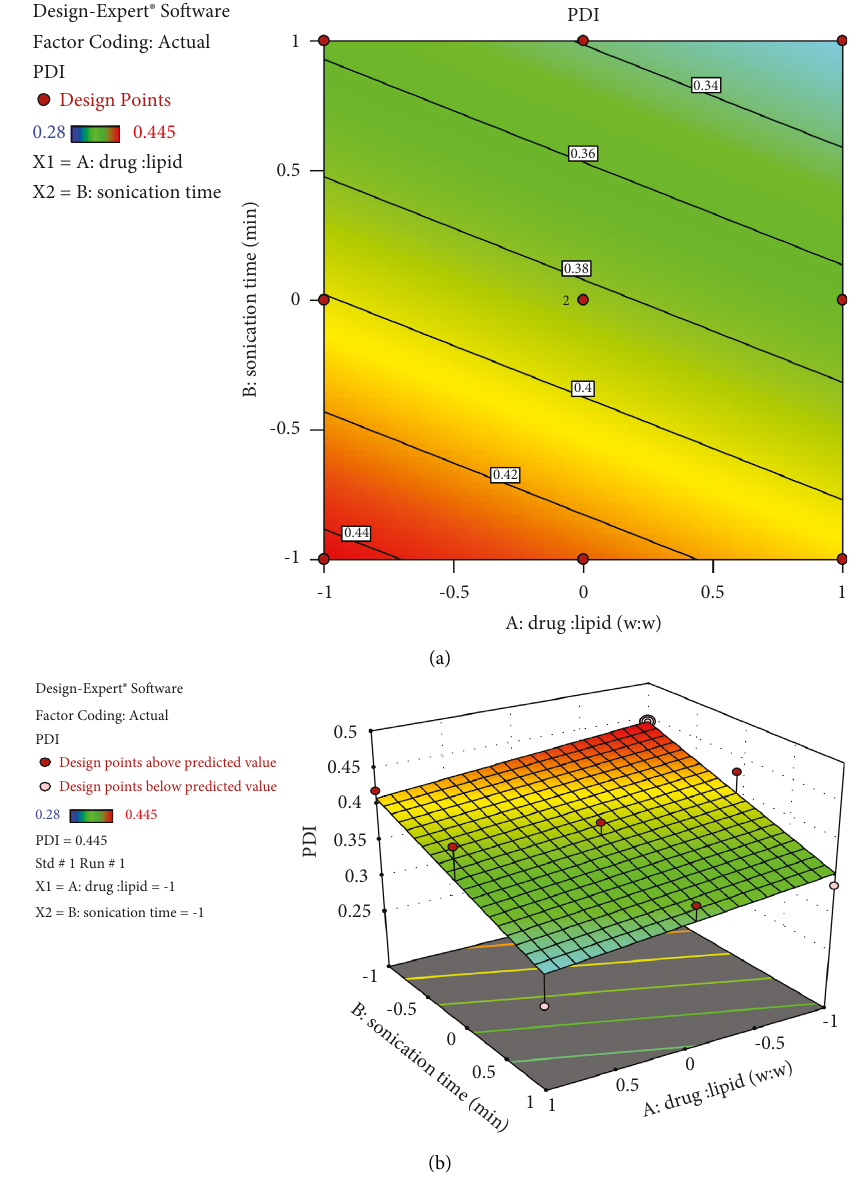
Figure 2: (a) Contour plot of polydispersity index against drug: GMS ratio (w:w) and sonication time (min) and (b) 3D surface plot of polydispersity index against drug: GMS ratio (w:w) and sonication time